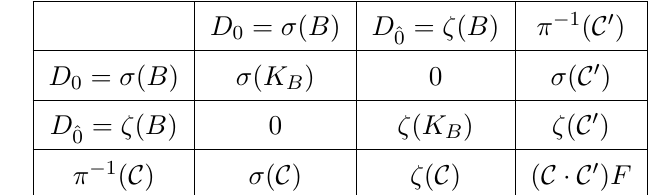
Table 4 . Intersection properties of curve classes and divisor classes. Here, C and C 0 are two curve classes on the base.